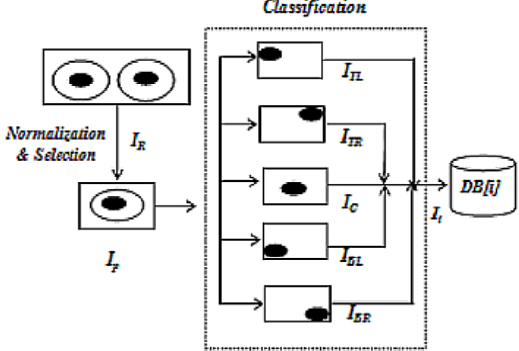
Figure 3: Gaze estimation quadrants used for mapping M directions in GDE experimental setup.